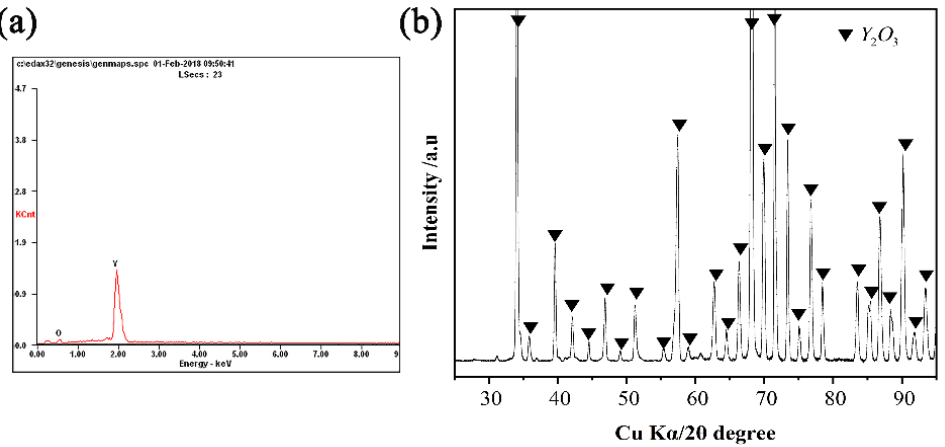
Figure 7. EDS and micro-XRD patterns of the metal/MgO substrate interface.